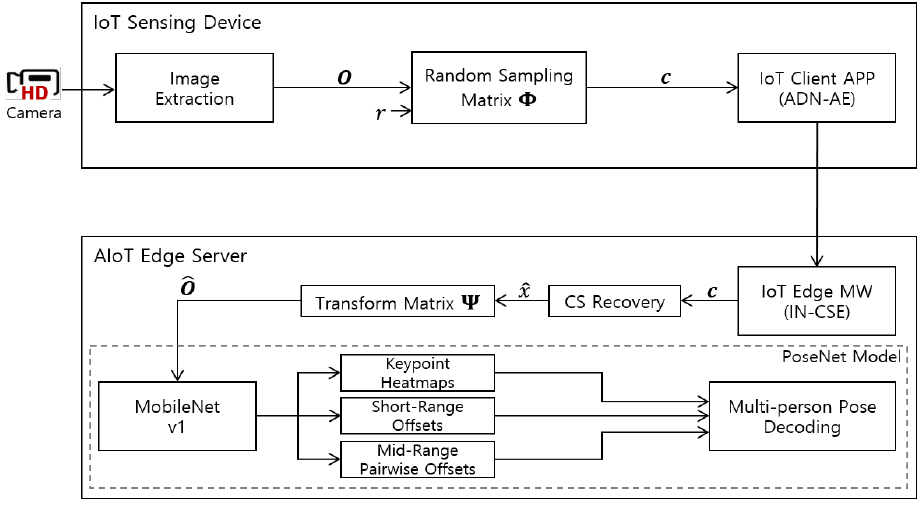
Figure 1. Proposed AIoT system with an IoT sensing device for CS and an AIoT edge server for CS recovery and pose